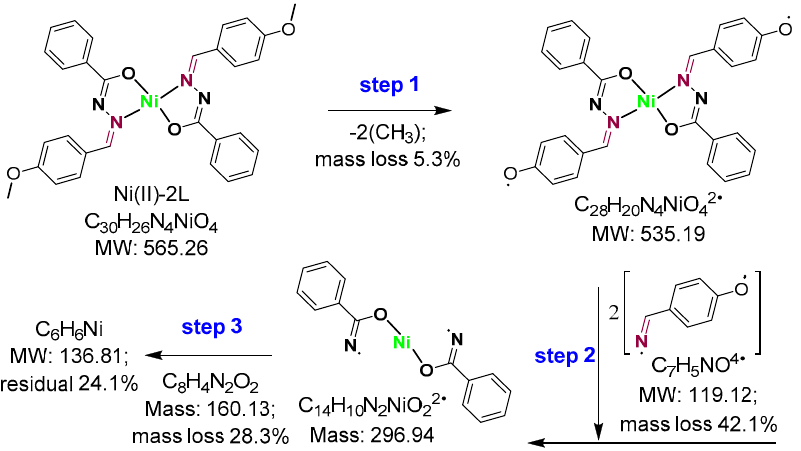
Figure 6. Thermogravimetric analysis (TGA) (black), derivative (Dr)-TGA (blue), and differential thermal analysis (DTA) (red) curves of ( A ) the N'-(4-methoxybenzylidene)benzohydrazide (HL) ligand and ( B ) its nickel complex (Ni(II)-2L).